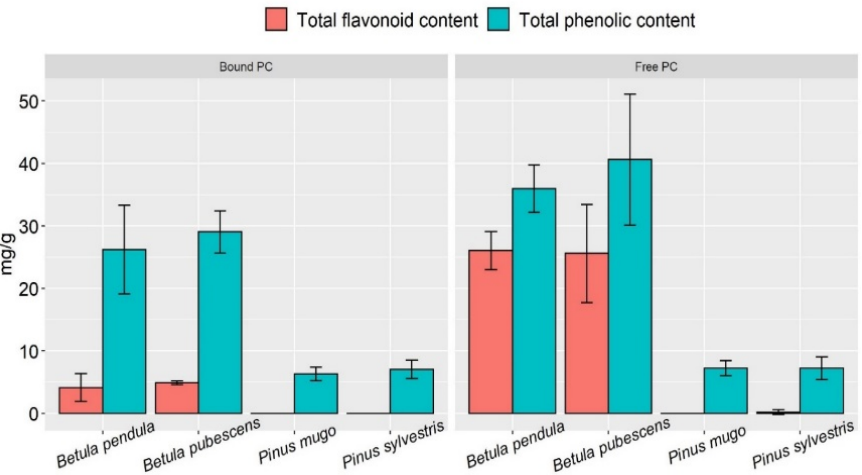
Figure 1. Total content of free PC, bound PC and flavonoids in Betula and Pinus pollen extracts.